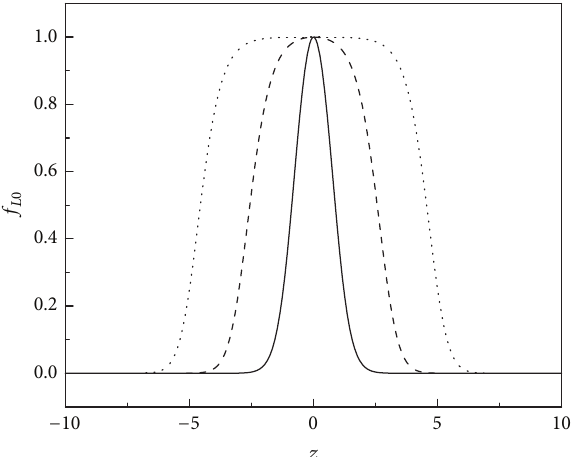
Figure 3: Fermion zero modes localized on the brane: 𝑎 = 1 (solid line), 𝑎 = 3 (dashed line), and 𝑎 = 5 (dotted